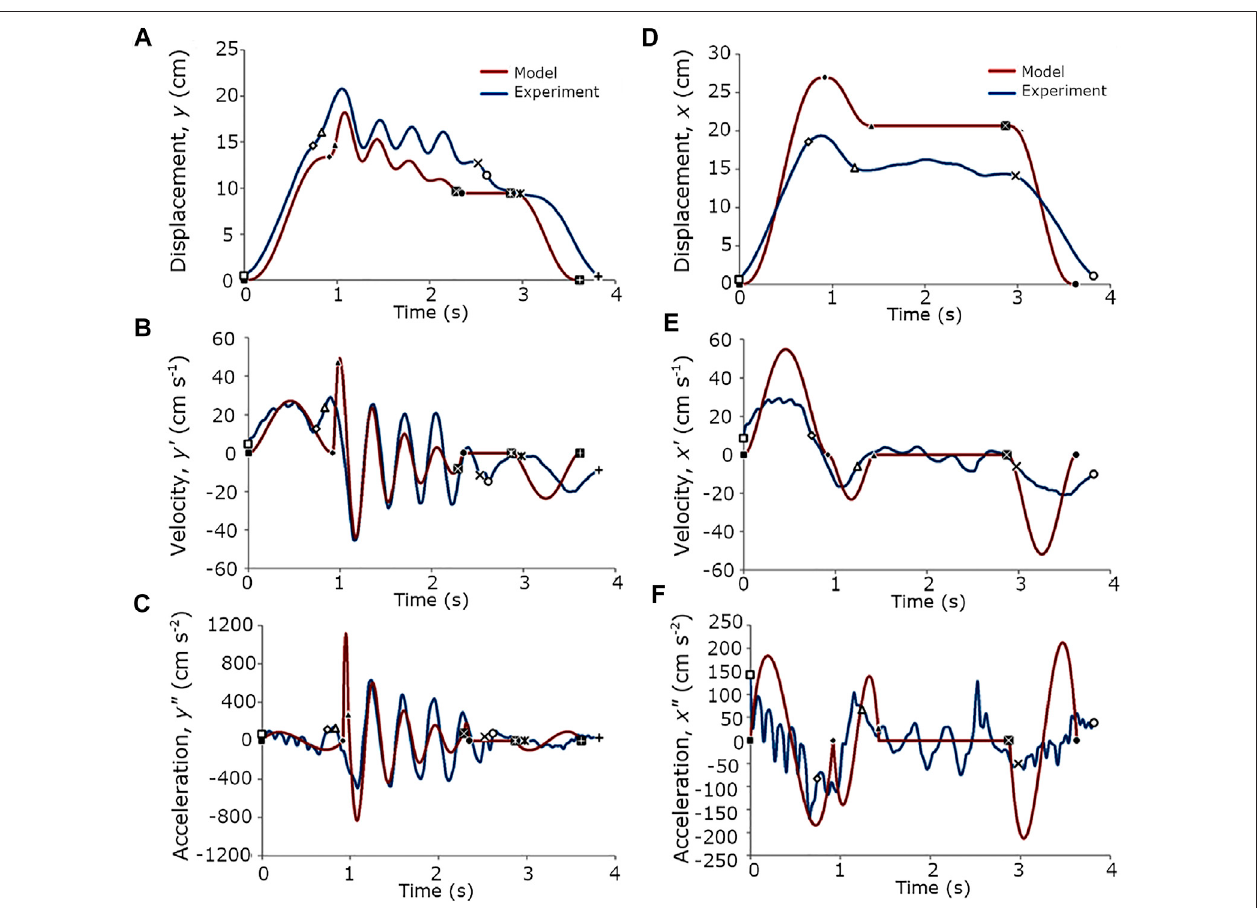
FIGURE 4 | Comparisons between the model and experiments. (A – C) y -axis position, velocity, and acceleration, respectively. (D – F) x -axis position, velocity, and acceleration, respectively. The experiment curves came from the mean of the collected data.